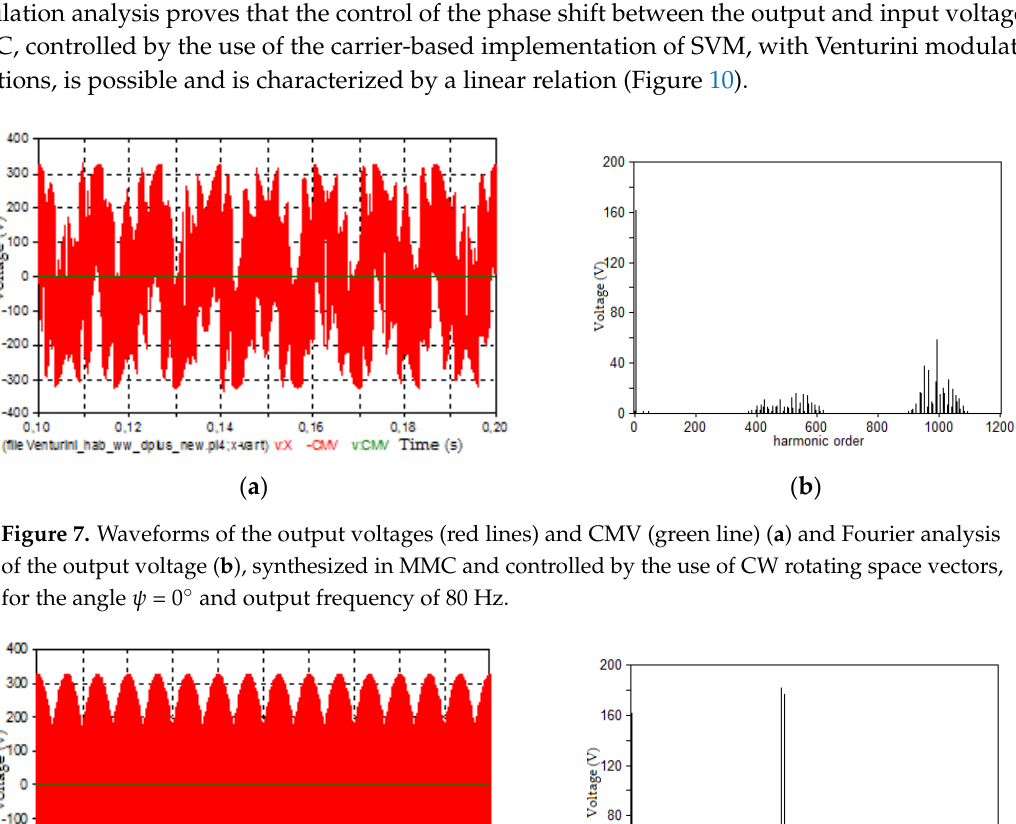
Figure 8. Waveforms of the output voltage (red lines) and CMV (green line) ( a ) and Fourier analysis ( b ) of the output voltage, synthesized in conventional MC by the use of CCW rotating space vectors, for the output frequency of 50 Hz.